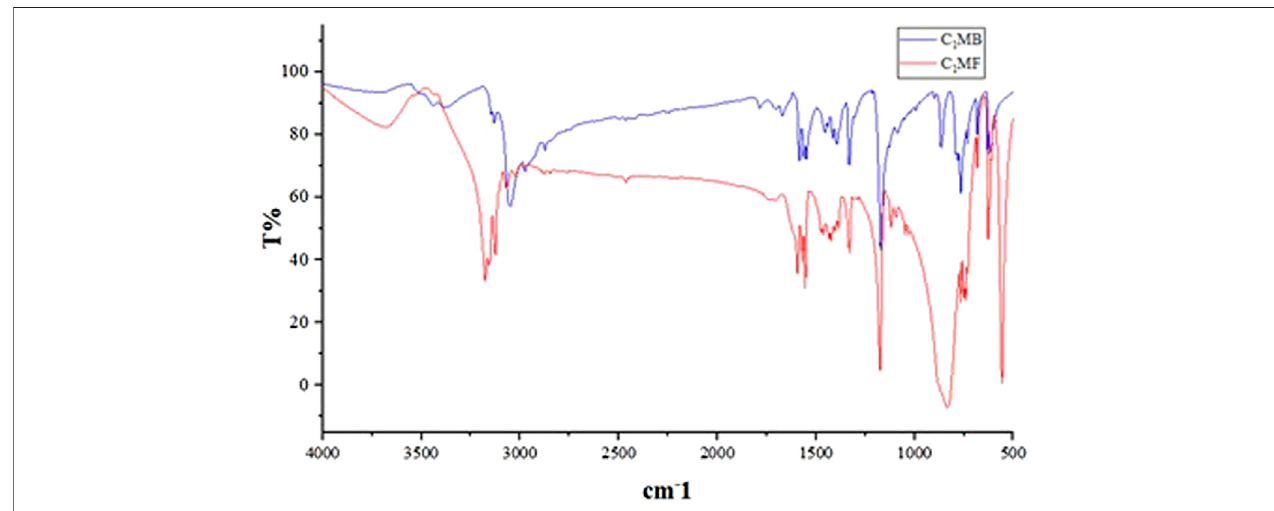
FIGURE 3 | IR of the C 1 MB and C 1 MF.